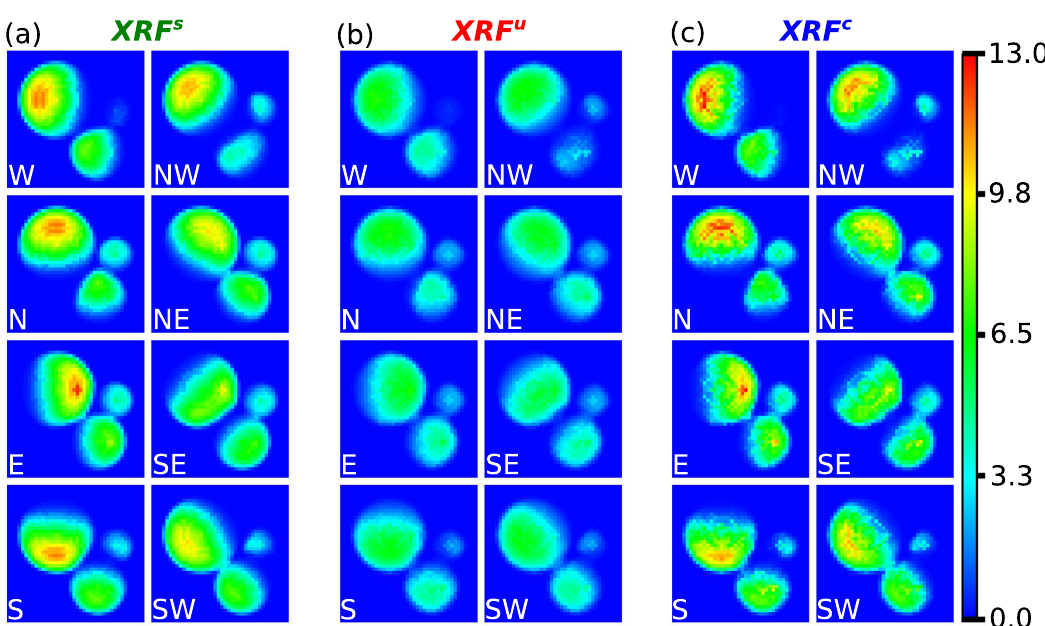
s u c data ( a ), XRF data ( b ) and XRF data ( c ) respectively,